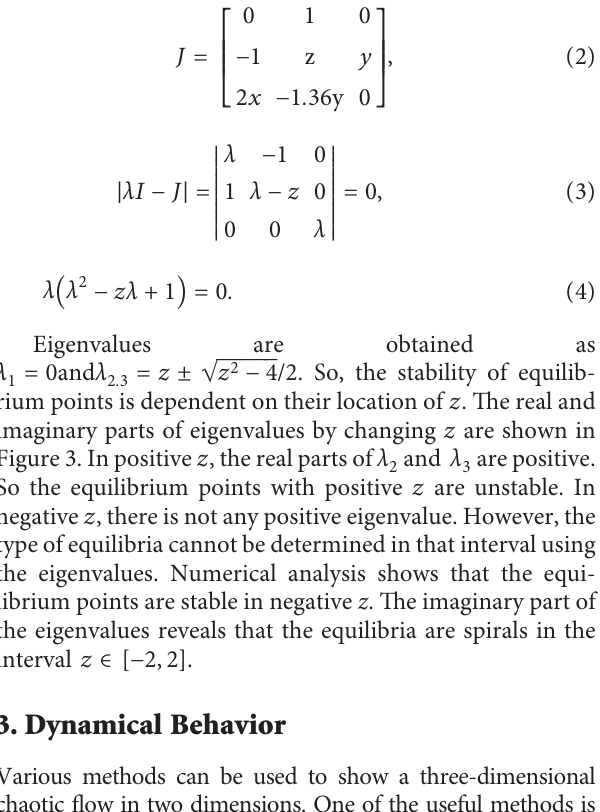
Figure 4. The values of the Poincare section are the values of trajectories crossing the plane z � 0. The symmetry of the oscillator’s dynamics can be seen in this